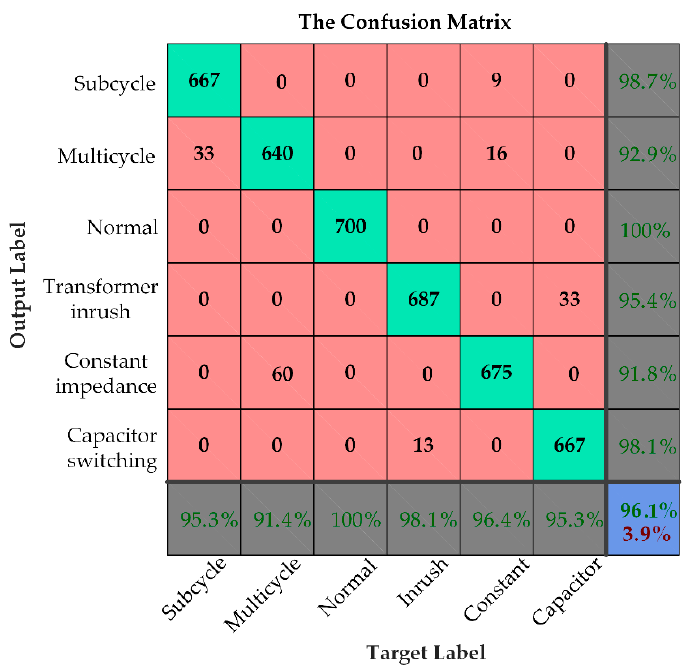
Figure 10. The results of the classification confusion matrix based on VMD and CNN.